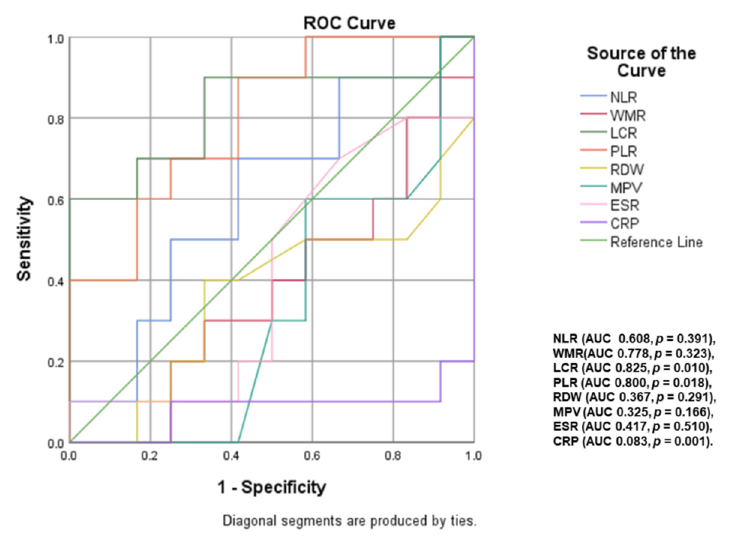
Figure 5. Inflammatory parameters with a predictive role for CPAP adherence in patients with moderate OSA (NLR: neutrophil–lymphocyte ratio; WMR: white blood cell count-to-mean platelet volume ratio; LCR: lymphocyte-to-CRP ratio; ESR: erythrocyte sedimentation rate; CRP: C-reactive protein; PLR: platelet-to-lymphocyte ratio; RDW: red cell distribution width; MPV: mean platelet volume).